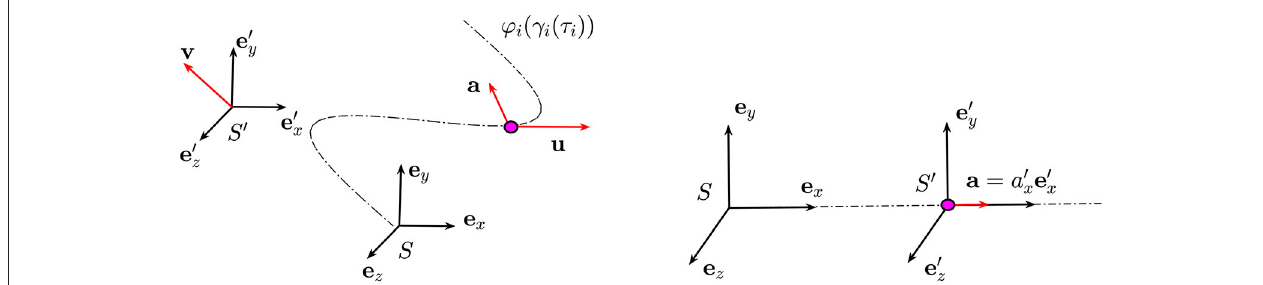
FIGURE 4 | On the left) The particle (purple dot) is moving along a trajectory with velocity u and acceleration a . On the right) The frame of reference S ′ is moving at constant velocity v away from S : the components of the velocity and the acceleration of the particle in these two frames of references are related by Equations (A.1) and